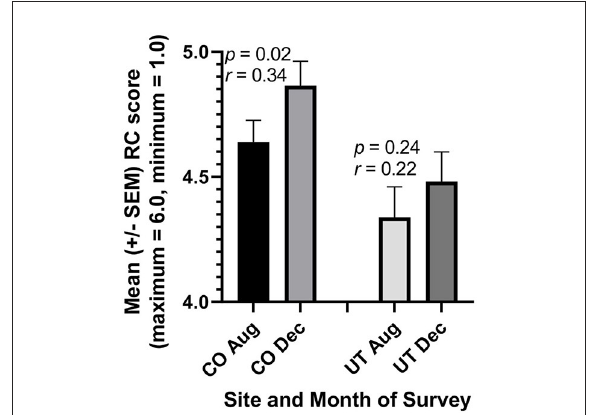
FIGURE3 Prospective medical students Reflective Capacity (RC) scores